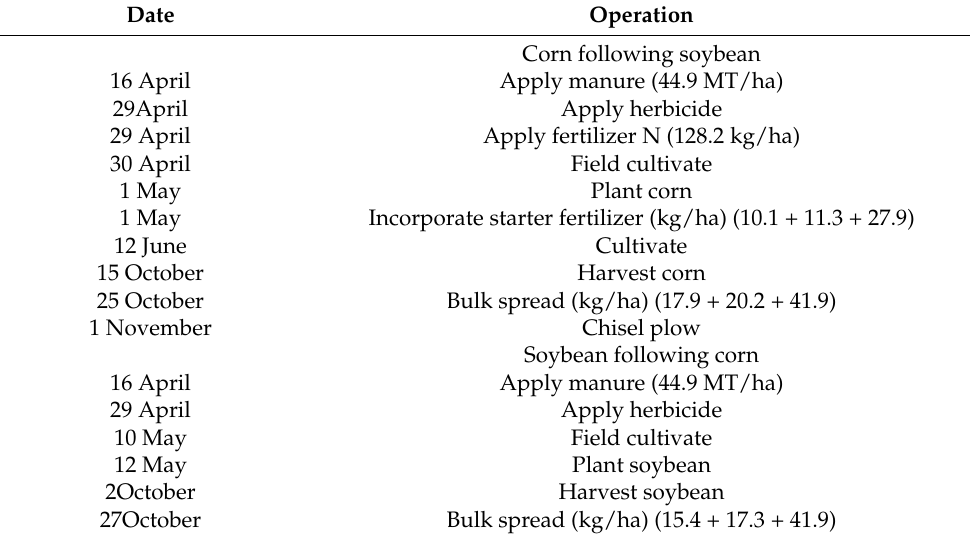
Table 2. Field operations simulated for corn–soybean rotation for 1998–2000 production years